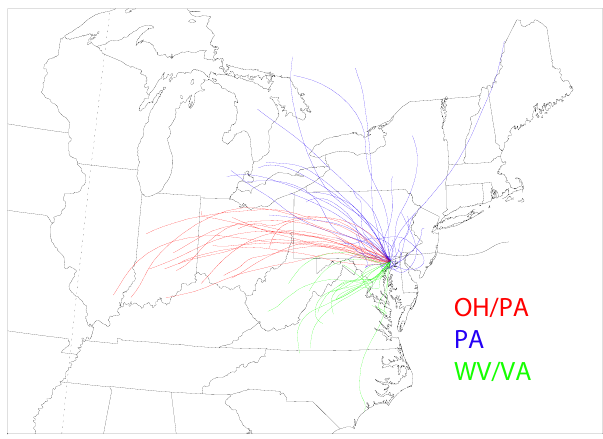
Fig. 12. Clustering results of HYSPLIT back trajectories (initiated at 1000m) from historical RAMMPP research flights over Harford County airport. The air parcels have origins from the west (OH/PA cluster shown in red), the northwest (PA cluster shown in blue), or the southwest (WV/VA cluster shown in green). The black line shows a single trajectory for a flight conducted on 3 September 2009 called a background flight, with air flow from the east.